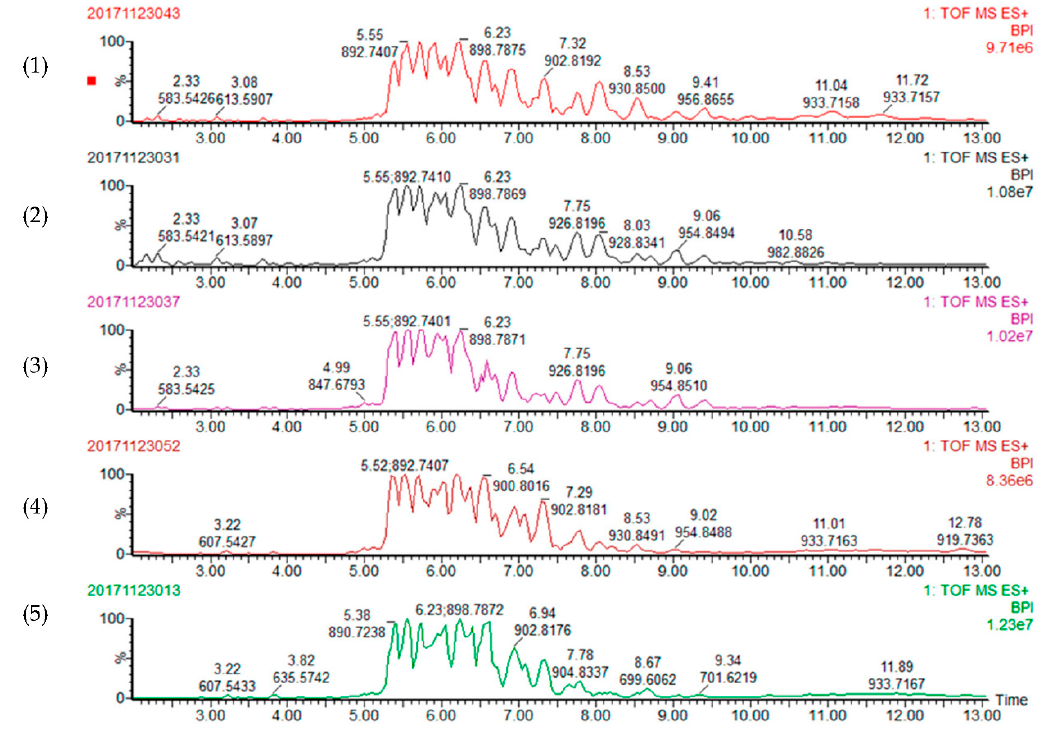
Figure 1. Representative UPC 2 -QTOF MS base peak intensity (BPI) chromatograms of the triacylglycerols from ( 1 ) blackberry, ( 2 ) red raspberry, ( 3 ) black raspberry, ( 4 ) blueberry and ( 5 ) cranberry seed oil samples.